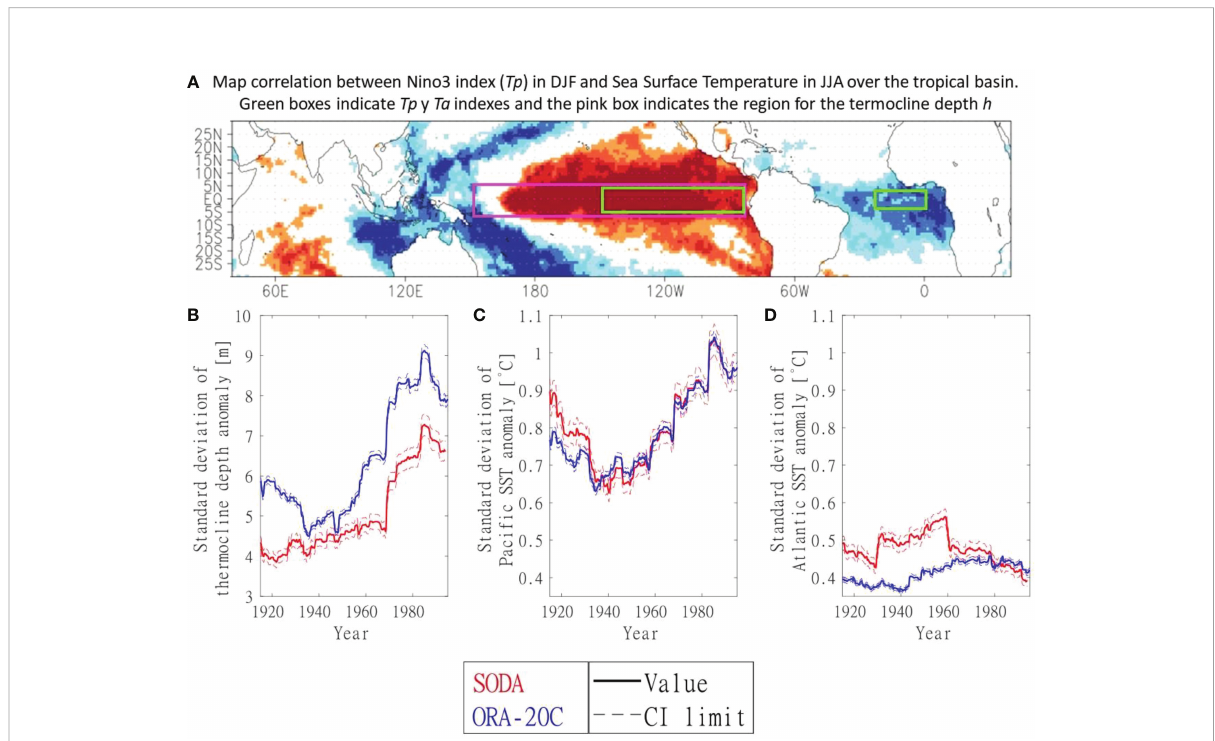
FIGURE 1 Climate indexes: (A) Map representing the boxes for the three indexes T P , T A (green boxes in the Paci fi c and Atlantic, respectively) and h (pink box). The shaded areas represent the correlation between the Nino3 index (T P ) in DJF and SST in previous summer JJA. Red (blue) colors represent positive (negative) rank correlations. (Panels B-D ) Characteristic amplitude of the indexes anomalies: Paci fi c thermocline depth e h (B) , Paci fi c temperature e P (C) and Atlantic temperature e A (D) anomalies, calculated as the standard deviation of the anomalies in each 30-year long time window, for SODA (red) and ORA-20C (blue) reanalysis. Solid lines represent the value of the parameter, and dashed lines show the con fi dence intervals of the standard deviation, as calculated in Supplementary Appendix (D) Each point of the fi gure considers a time window of 30 years, and the represented year in the horizontal axis is the mean value of that